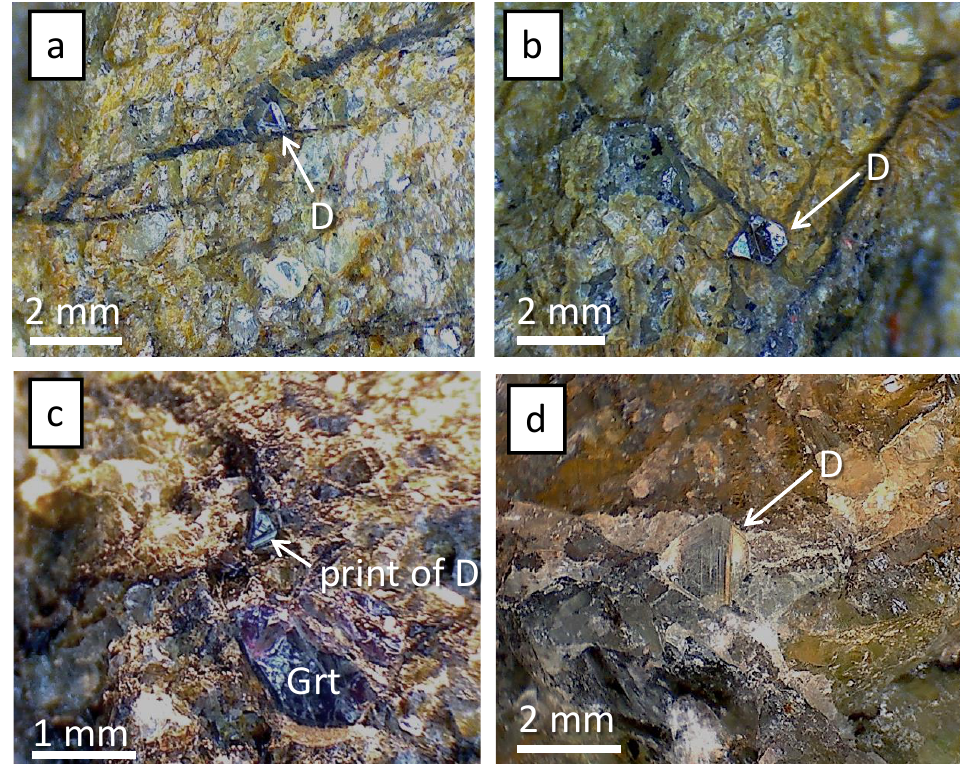
Figure 1. Diamonds ( d ) in the cracks in olivine of megacrystalline dunites from the Udachnaya kimberlite pipe (Yakutia, Russia): ( a , b ) U-69/76; ( c ) U-450/89; ( d ) LUV-833.